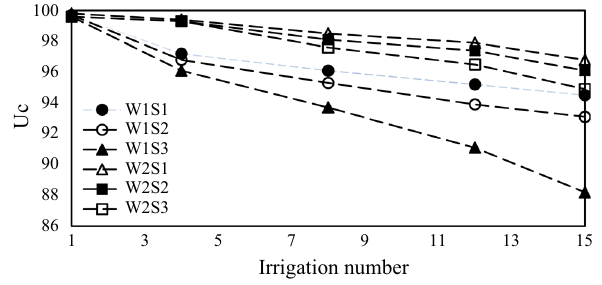
Fig. 5 Variations of Christiansen’s coefficients of uniformity during the experiment period